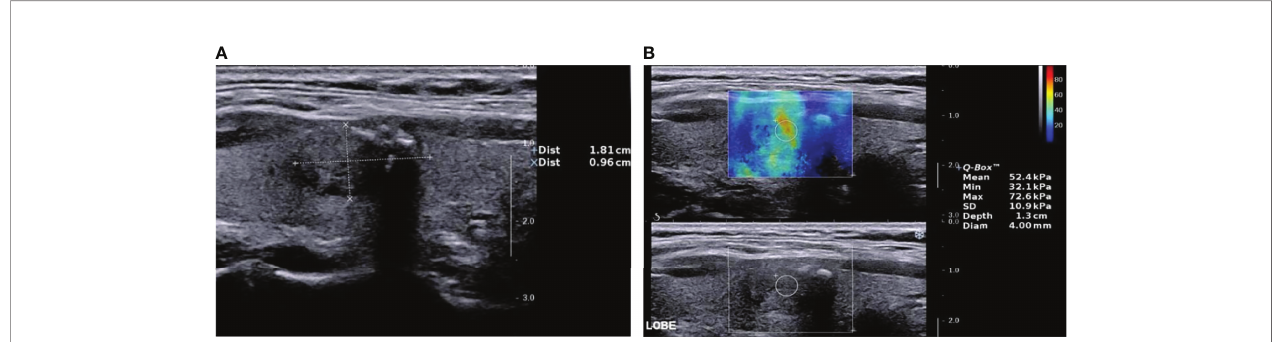
FIGURE 1 | Nodular goiter (shear wave elastography false-positive nodule) by two-dimensional ultrasound and elastic ultrasound. (A) A solid isoechoic nodule in the middle of the right lobe of the thyroid, 18.1 × 9.6 mm, with an ill-de fi ned margin and coarse calci fi cation. The ACR – TIRADS score was 4 and ACR – TIRADS category was 4. (B) The Emax value of the nodule on SWE imaging was 72.6 kPa.